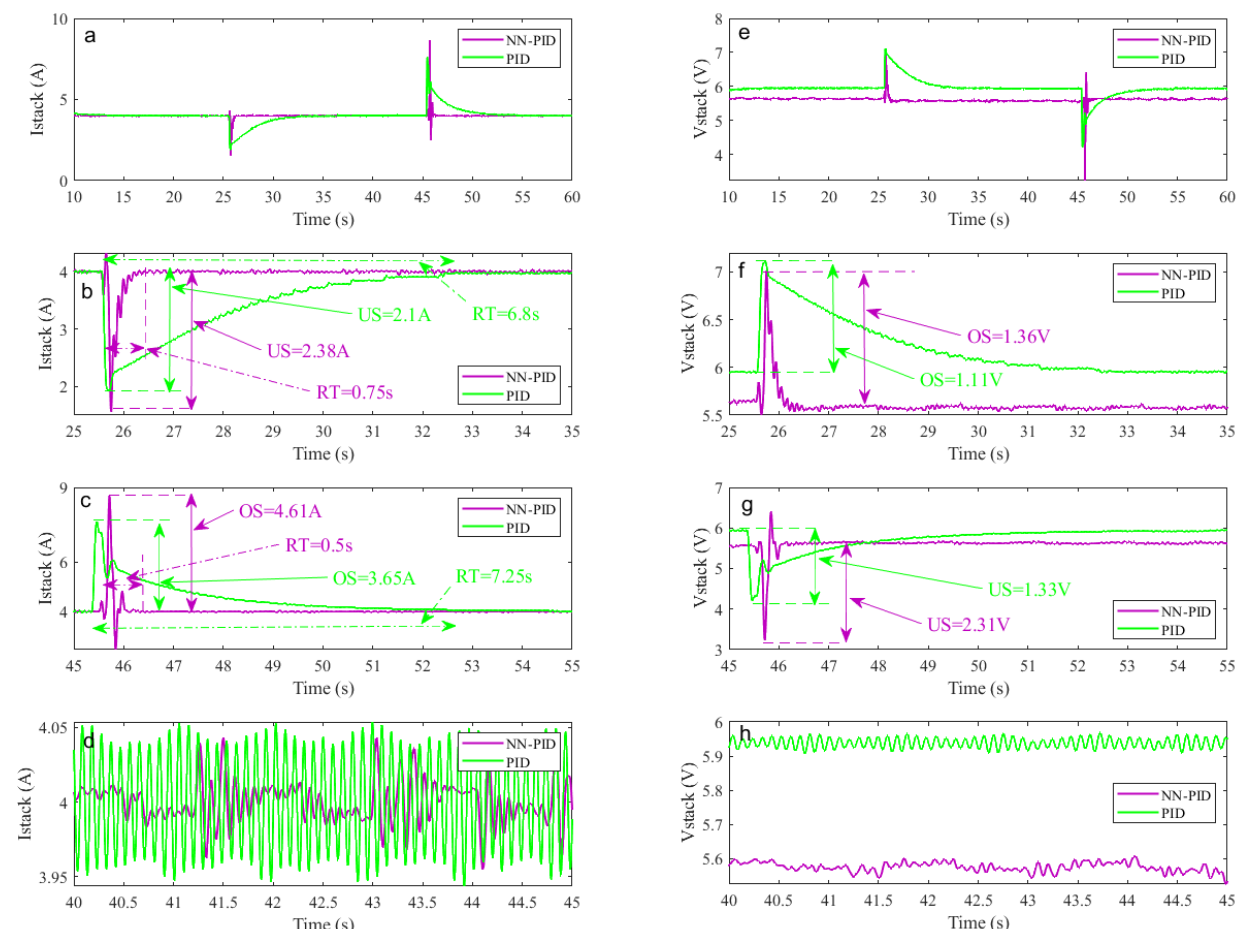
Figure 12. PID and NN-PID experimental results; ( a – d ): PEMFC stack current signal; ( e – h ): PEMFC stack voltage